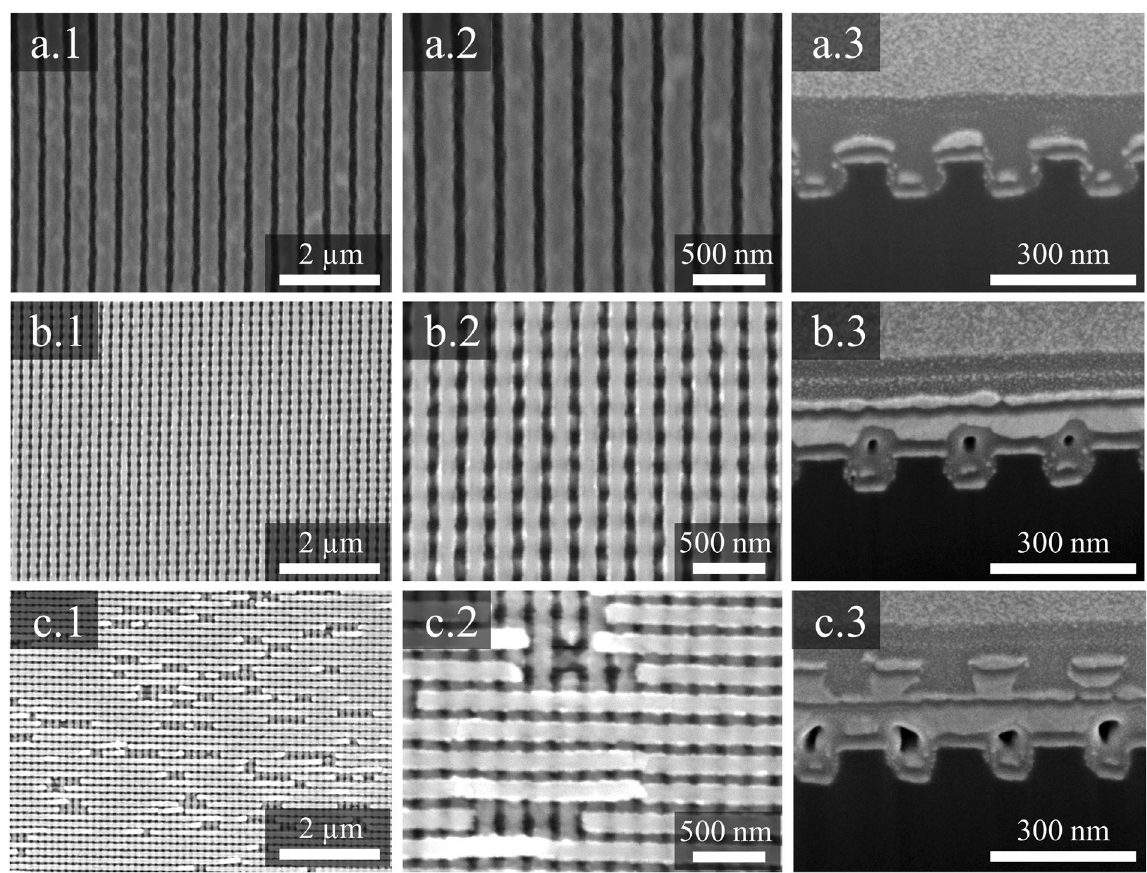
Figure 3. Top and cross-sectional SEM and FIB images of the fabricated samples: ( a . 1 ), ( a . 2 ), and ( a . 3 ) shows low-magnification, high-magnification, and cross-sectional images of Ag/TiO 2 nanocomposite wires, respectively; ( b . 1 ), ( b . 2 ), and ( b . 3 ) show low-magnification, high-magnification, and cross-sectional images of two-layer Ag/TiO 2 nanocomposite cross architecture, respectively; ( c . 1 ), ( c . 2 ), and ( c . 3 ) show low- magnification, high-magnification and cross-sectional images of three-layer Ag/TiO 2 nanocomposite cross architecture,